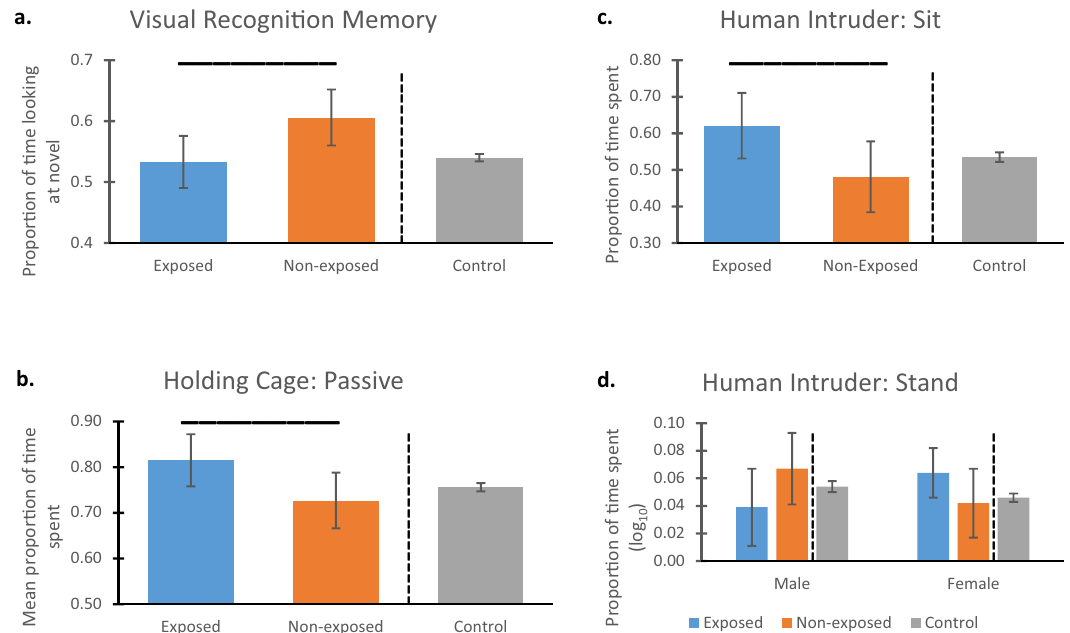
Fig. 3 Memory and behavioral data. Statistical comparisons between monkeys exposed vs. non-exposed (blue and orange bars, respectively) to wild fi re smoke prenatally show that, compared to non-exposed animals, those exposed to WFS ( a ) had signi fi cantly poorer performance on a visual recognition memory task ( p = .023), b showed signi fi cantly more passive behavior ( p = .037), c showed signi fi cantly more sitting ( p = .039), and d showed a signi fi cant interaction of exposure condition by sex for stand, ( p = .041) (no follow-up comparisons were signi fi cant). Overhead bars indicate signi fi cant differences. All values shown are means of raw data (except for stand, which was log 10 -transformed) and 95% Con fi dence Intervals (CI). All values are adjusted for the covariate. Data for b were from the Holding Cage observations, and data for c and d were from the Human Intruder assessment. To the right of the dotted lines are the corresponding values for the full control cohort (mean, 95% CI). Comparison of the overlap in CI between the groups in the target cohort with the control cohort revealed that, for the memory task a , controls showed complete overlap with the exposed animals, but did not overlap with non-exposed animals; neither the control nor non-exposed animals ’ CIs included the chance response value of 0.5, however. For passive b , CI of control animals overlaps completely with those from the non-exposed group; there is less overlap with CI in the exposed group for passive. c Controls ’ CI overlap completely with those in the non-exposed group, and less completely with the CIs in the exposed group. d CI for control animals overlapped completely with both groups from the target cohort for males, but there was less overlap between controls and exposed females. For the exposed, non-exposed, and control groups, respectively, sample sizes were n = 52, 37, 2381 for visual recognition memory; n = 52, 37, and 2490 for passive; and n = 52, 37, and 2486 for sit and stand. Source data are presented in a Source Data fi